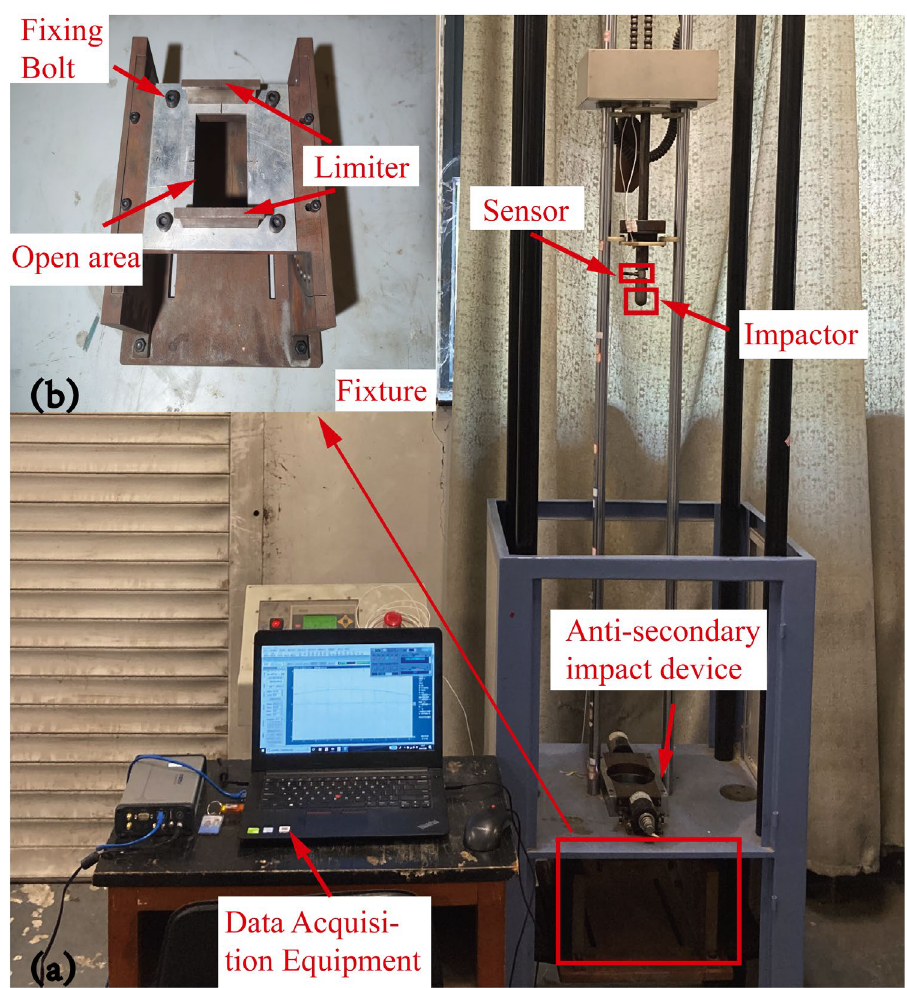
Figure 4. Drop-weight test system. ( a ) Impact test platform, ( b ) Fixture.